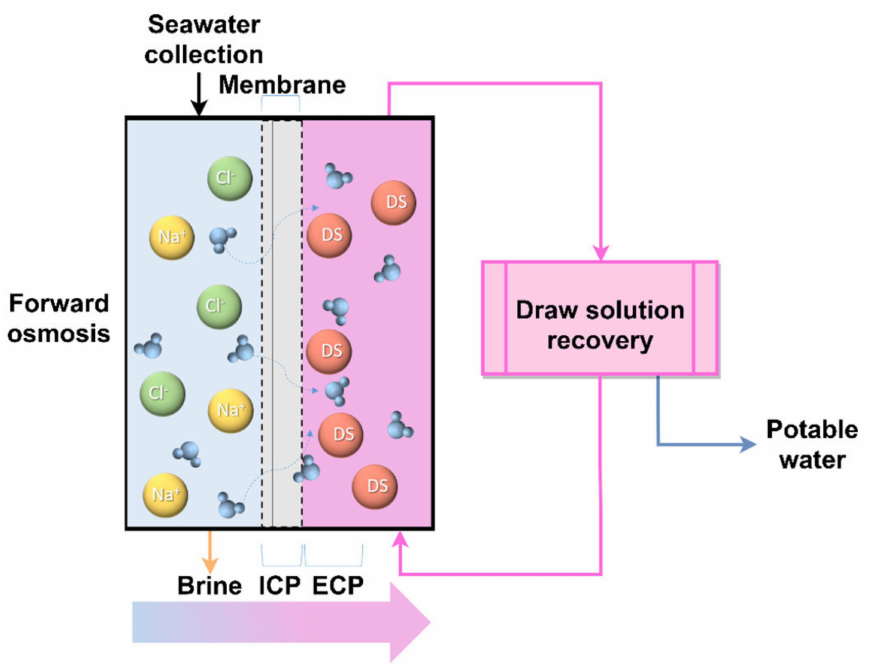
Figure 2. Forward osmosis diagram of the areas in which the internal and external concentration. polarizations (ICP & ECP) occur. Taken from